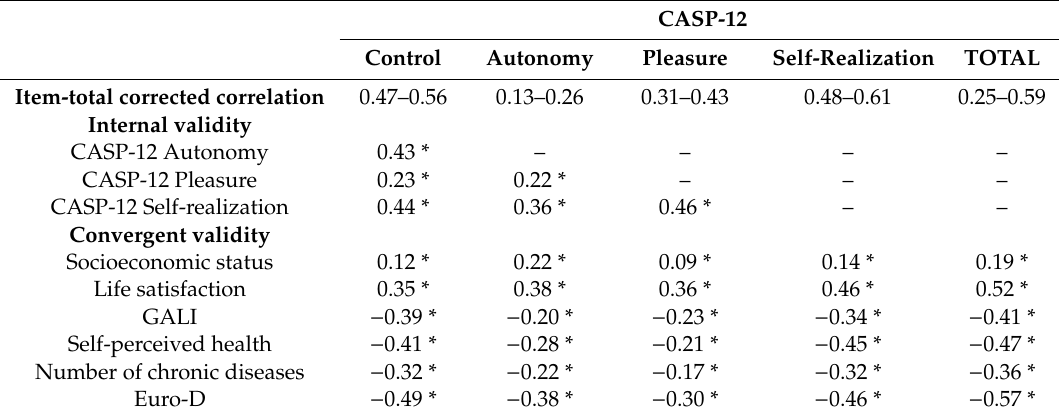
Table 3. Convergent and internal validity of